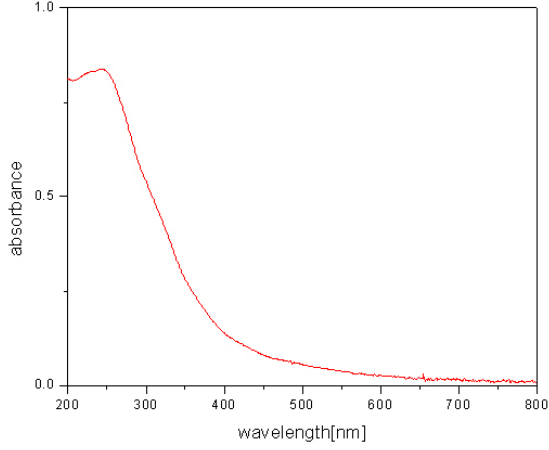
Figure 7. Optical absorption spectra of colloidal suspension